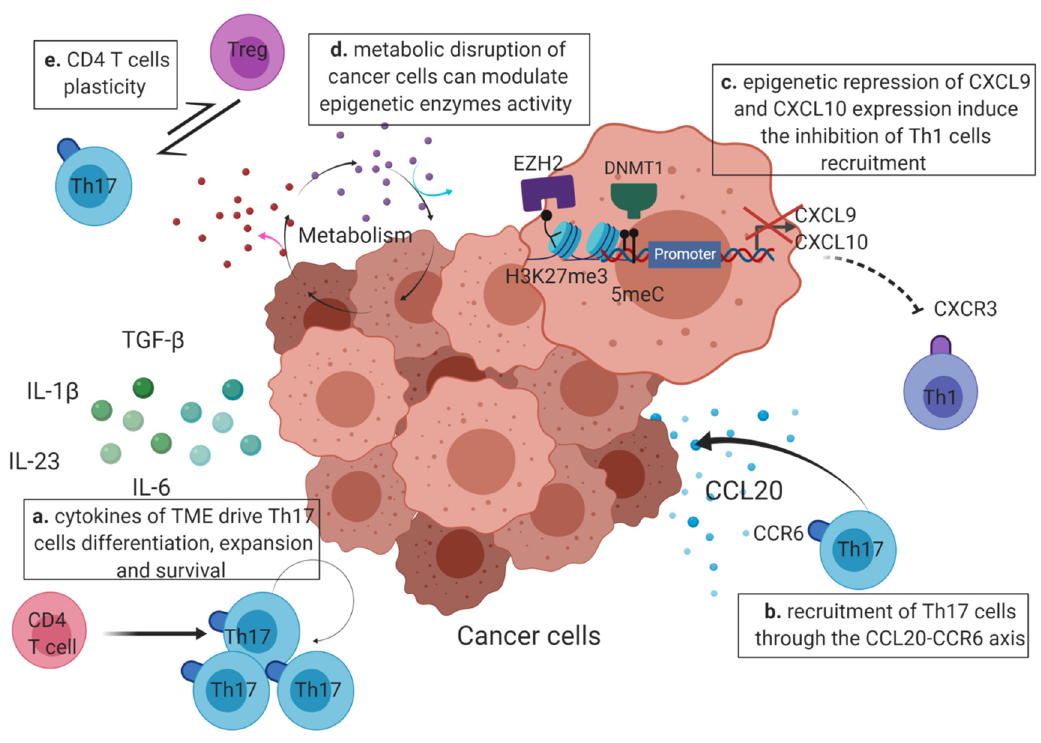
Figure 2. Factors regulating Th17 infiltration in the TME (tumor micro-environment). Th17-polarizing cytokines, like TGF- β , IL-6, IL-1 β , and IL-23, produced in the TME are responsible for Th17 differentiation, proliferation and survival (bold arrow) (a). Tumor specific Th17 cells already differentiated may also be recruited through the CCL20-CCR6 axis (curved arrow) where the chemokine CCL20 produced by tumor cells binds to the Th17 receptor CCR6 (b). Th17 predominance in the TME may also be explained by the inhibition of the recruitment of Th1 cells (dotted lines). Indeed, in cancer cells, EZH2 and DNMT1 can lead to the epigenetic repression of the Th1-attracting chemokines CXCL9 and CXCL10 by the apposition of the repressive histone marks (H3K27me3) and DNA methylation at the CXCL9 and CXCL10 promoters (c). The metabolic dysregulation occurring in cancer cells generate the release of metabolites in the environment that might further interfere with the activity of epigenetic enzymes in CD4 T cells and favor the expression of genes required for Th17 differentiation or functionality (d). Overall, the balance between Th17 and other CD4 T cells, like Tregs, can be modulated by the plastic capacities of these immune cells and induce the prevalence of Th17 cells at the tumor site. The possible conversion between Th17 and other CD4 T cells is represented by double arrows (e). Created with BioRender.com.